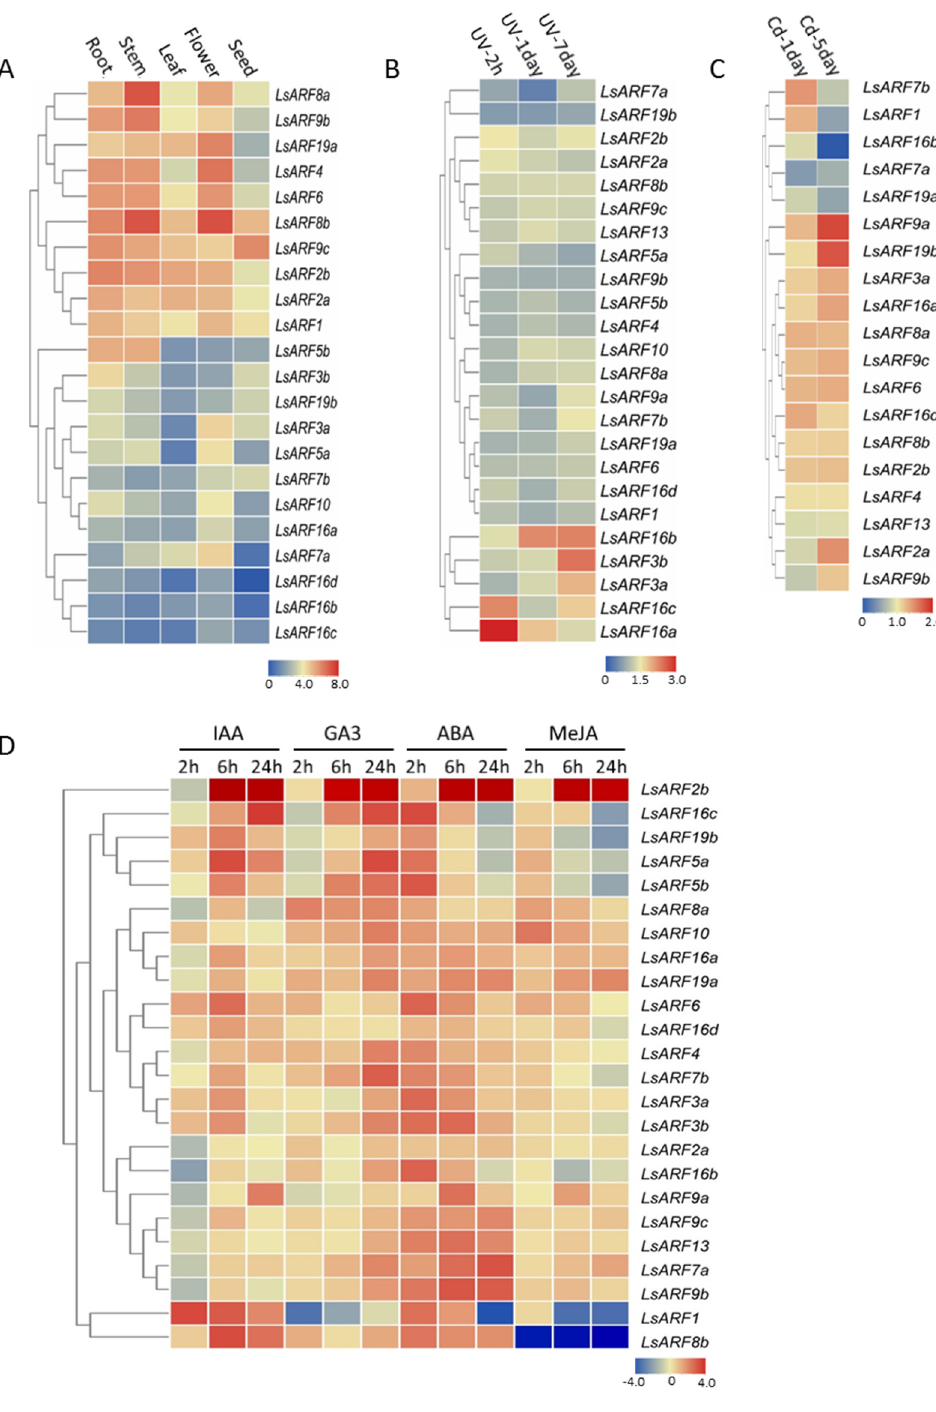
Figure 6. Expression profiles of LsARF genes. ( A ) Expression profiles of LsARF s with hierarchical clustering in different organs. ( B , C ) Heatmap representation and hierarchical clustering of LsARF s under UV treatments and cadmium stresses. ( D ) Heatmap showing expression patterns of the LsARF s under different phytohormone treatments. The FPKM value or normalized qRT-PCR data of representative transcripts of LsARF s was used to generate heatmap with hierarchical clustering on the basis of the Manhattan correlation with average linkage using the TBtools software package. The color scales below heatmap show the expression levels. Red indicates high transcript abundance, while blue indicates low abundance.